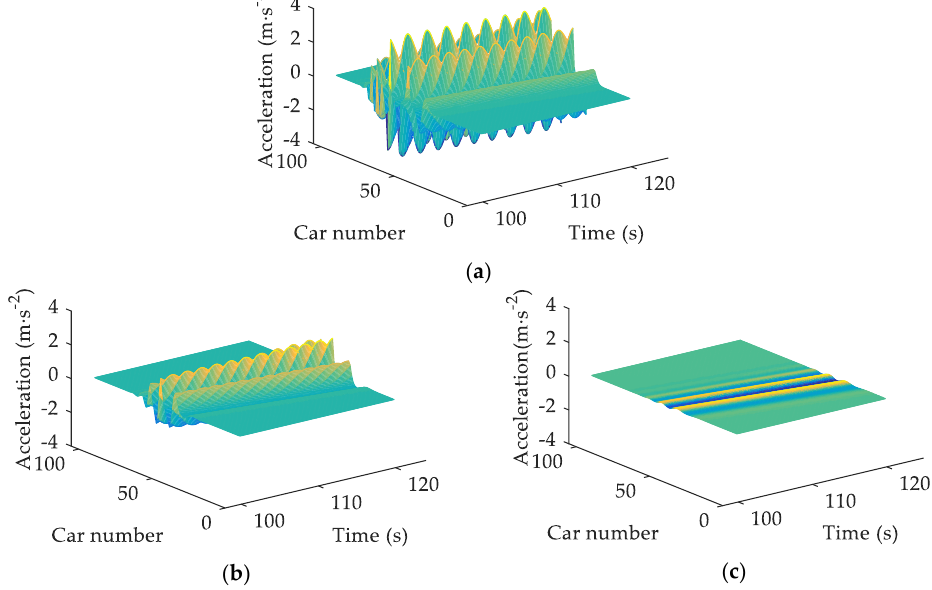
Figure 2. The space–time evolutions of acceleration under different β : ( a ) β = 0; ( b ) β = 0.2; ( c ) β = 0.4, . where α = 0.2, T = 1.2